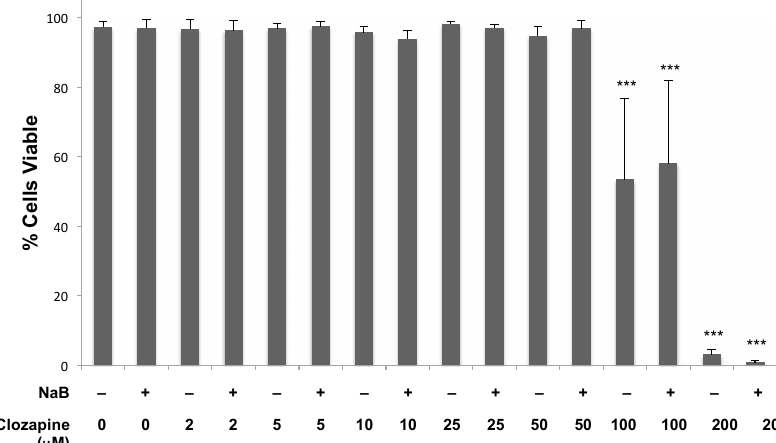
Figure 4. Cells remained viable when treated with 50 µ M clozapine for 24 h. Clozapine was tested at concentrations from 2–200 µ M in the presence and absence of NaB (3 mM) for the e ff ects on the viability of Burkitt lymphoma cells. Data from four or more biological replicates were averaged, and error bars represent the standard deviation. Conditions are not marked unless significantly di ff erent than untreated cells. Di ff erences with a p -value < 0.001 are denoted with ***.